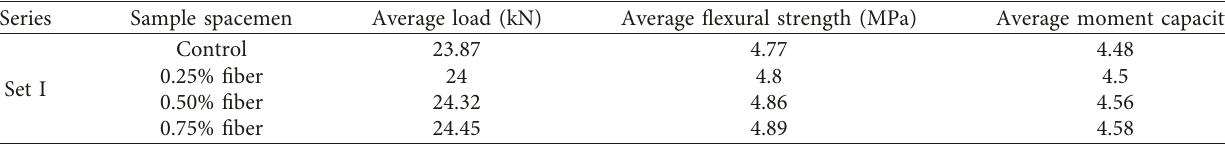
Table 5: Flexural strength of concrete 28 days test plain concrete beam samples.